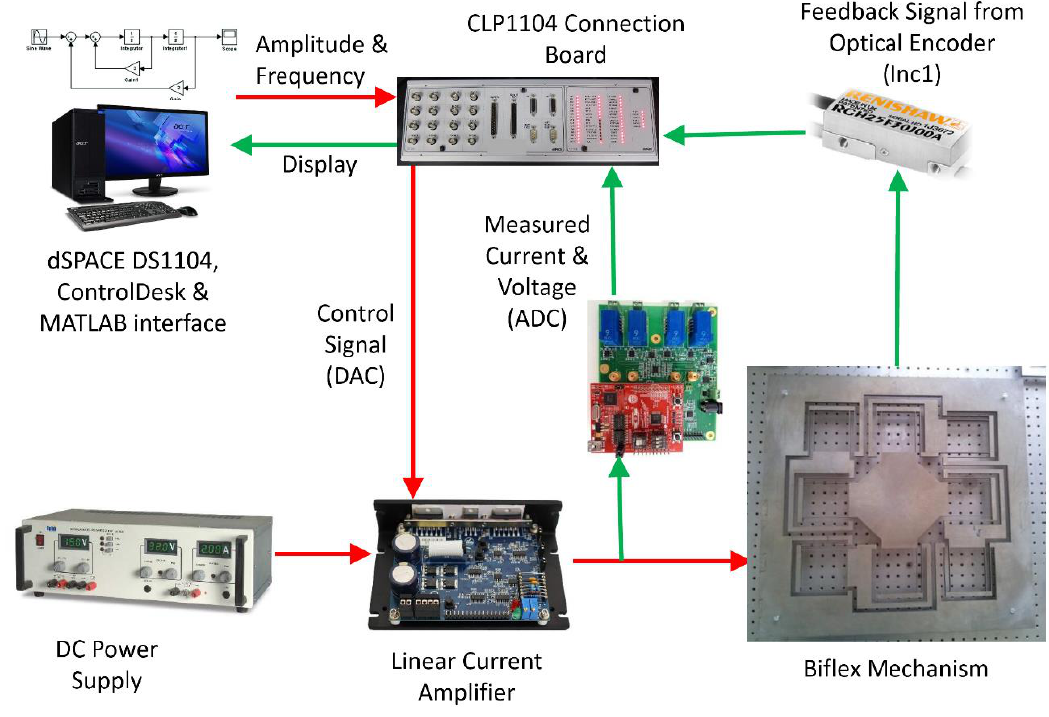
Figure 15. Experimental setup for sensorless validation.